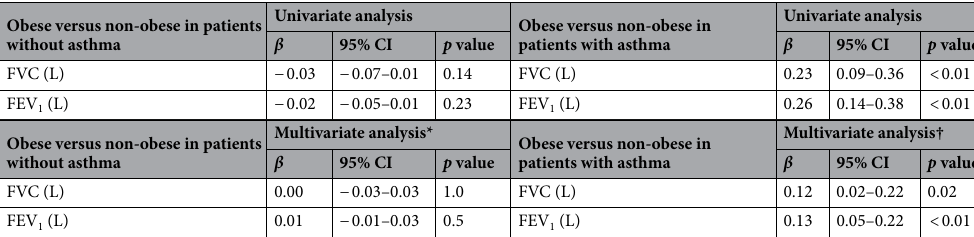
Table 4. Univariate and multivariate analyses of FVC and FEV 1 in obese patients without asthma versus non-obese patients without asthma and obese patients with asthma versus non-obese patients with asthma. FVC, forced vital capacity; FEV 1 , forced expiratory volume in 1 s; CI, confidence interval. *FVC and FEV 1 were individually adjusted by confounding factors including age, sex, and smoking history. † FVC and FEV 1 were individually adjusted by confounding factors including age, sex, smoking history and dose of ICS.